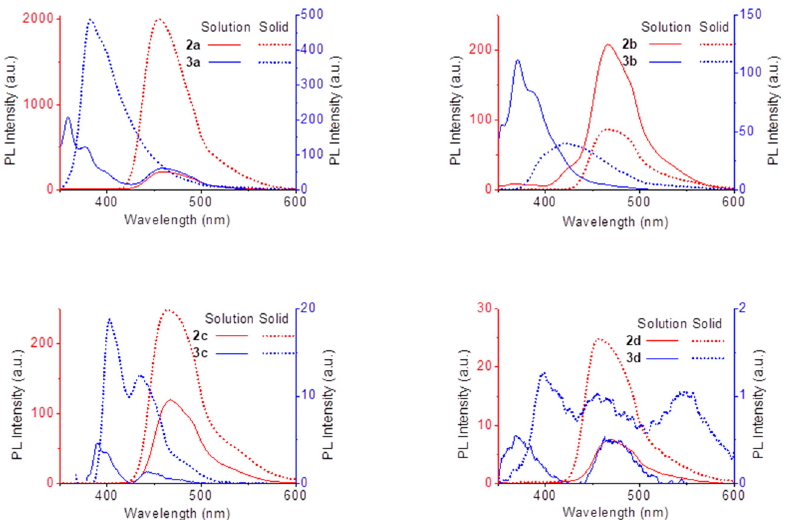
Figure 5. Emission spectra of ligands (red) and complexes (blue), in DMSO solutions (1.0 × 10 − 5 M, full line) and solid state (dotted line).